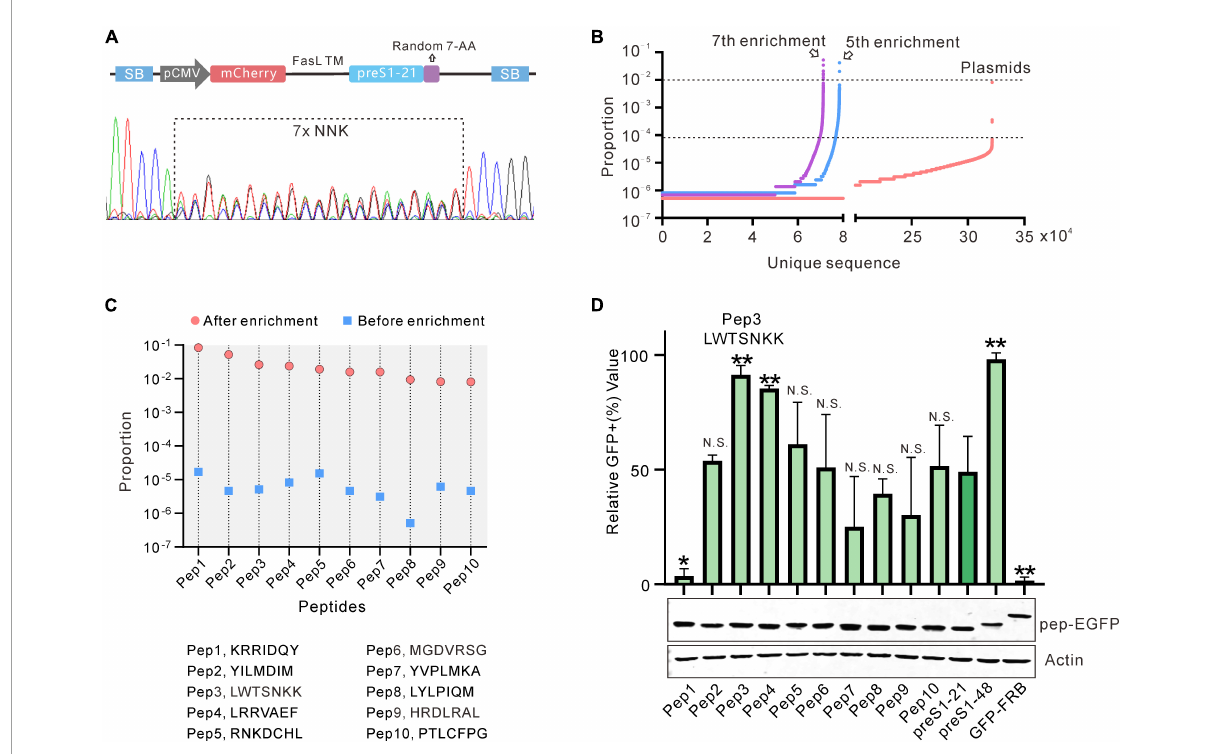
FIGURE3 Construction and screening of the random peptide library. (A) Sanger sequencing results of the library (PT4-21 + 7). (B) Deep sequencing results of the initial or enriched sequence. The number of unique sequences ( x -axis) and the proportion of each sequence ( y -axis) are shown. (C) The 10 sequences with the highest enrichment fold and proportion after 7 rounds of screening. (D) Evaluation of the 10 sequences selected by flow cytometry. The peptides fused with GFP were expressed by HEK293 cells and captured by the cells displaying NTCP-mCherry. Data are shown as means ± SD. Statistical significance was determined using the non-parametric Mann–Whitney U -test (* p < 0.05, ** p <